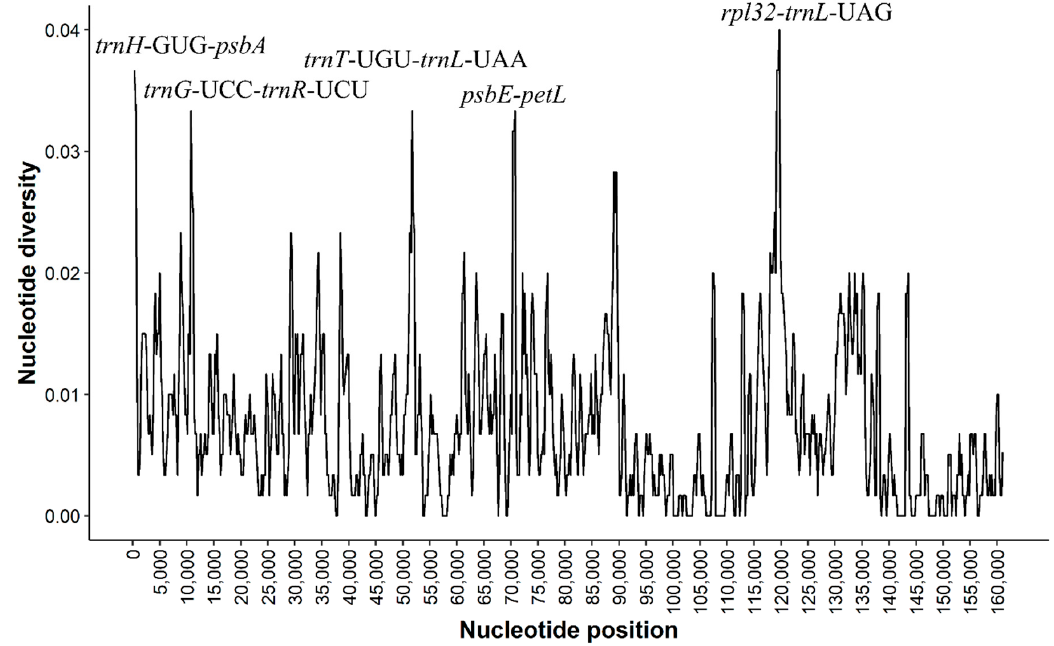
Figure 5. Results of the sliding window analysis of the complete plastid genomes of A. camansi and A. heterophyllus .